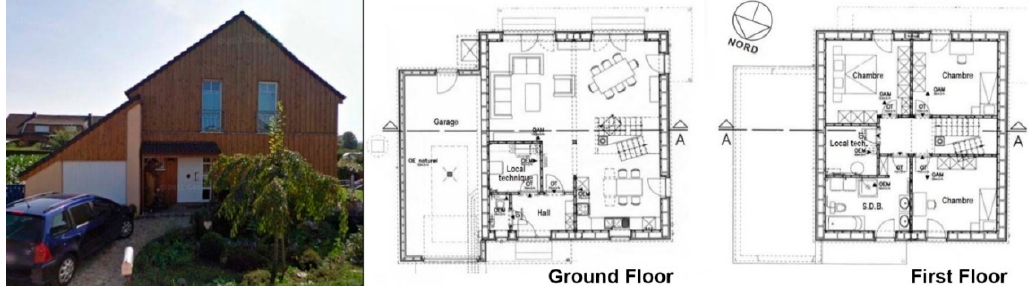
Figure 3. Freestanding single-family house, in Kettenis, Belgium (architect: Leo Michaelis) [19,26,27].